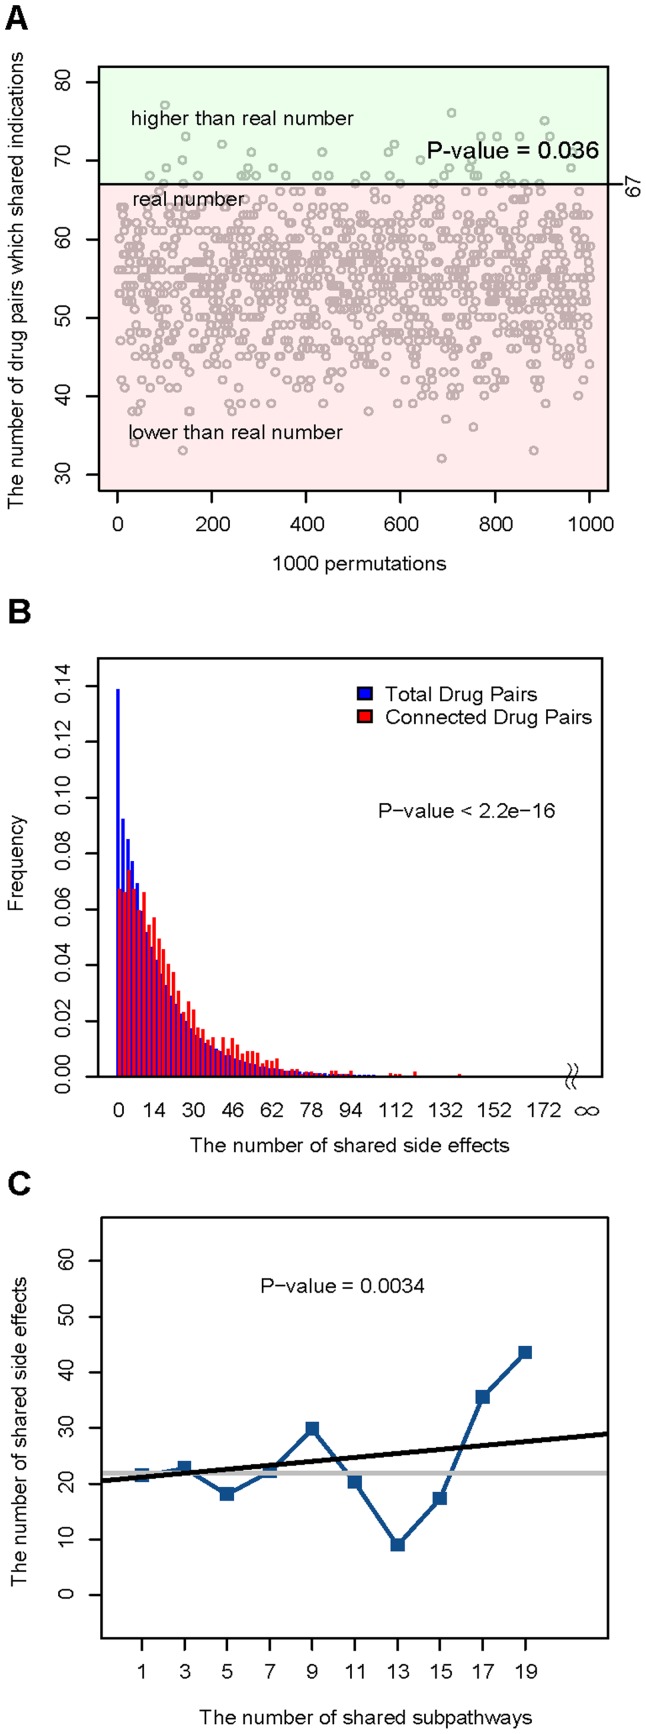
The relationship between drug dual effects and metabolic subpathways in the DRSN.(A) Of 1586 connected drug pairs (drugs that were linked to the same subpathways), 67 shared the same indications, compared to 55 drug pairs on average of 1000 randomized 1586 drug pairs. Of 1000 times randomized 1586 drug pairs, there were only 36 times when the number of drug pairs which shared the same indications were more than 67 (P-value = 0.036). (B) The number of side effects shared by connected drug pairs was significantly higher than the number of side effects shared by all drug pairs in the SIDER database (P-value <10). (C) The number of shared side effects significantly increased as the number of the shared subpathways increased between two drugs (P-value = 0.0034). The grey horizontal line is the average number of side-effects all drug pairs shared. The Y axis represents the number of side-effects shared by drug pairs. The X axis represents the number of the same subpathways drug pairs shared. Blue “▪” symbols correspond to the binned average number of side-effects shared by drug pairs. The linear regression model (black line) is used to test the trends in correlations and the significance of the trends is estimated.